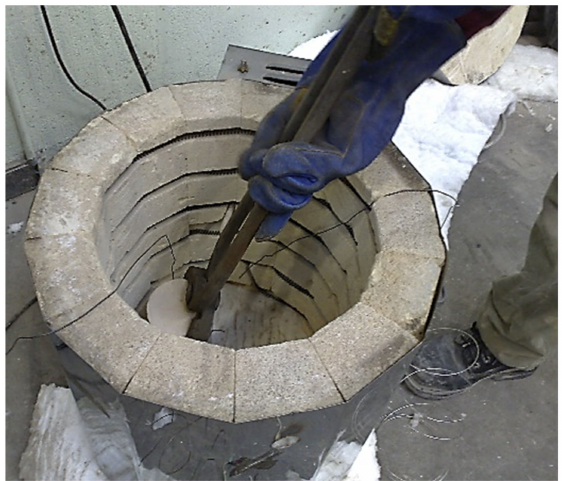
Figure 2. Electric furnace.